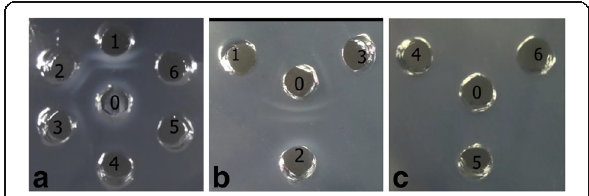
Fig 3 Immunological assessment of anti- D. acutus venom IgY against venom from five species of snakes found in China by immunodiffusion assay. a In the central well (0): D. acutus venom (30 μ g); in the peripheral wells: (1) anti- D. acutus IgY crude extract (1200 μ g); (2 – 5) the serial dilutions (1:2, 1:4, 1:8, and 1:16, respectively) of the crude extract; (6) physiological saline. b and c In the central well (0) anti- D. acutus IgY crude extract (1200 μ g) whereas the the peripheral wells contained 30 μ g of the following: (1) T. albolabris venom; (2) D. acutus venom; (3) D. saxatilis Emelianov venom; (4) B. multicinctus venom; (5) N. atra venom; and (6) physiological saline